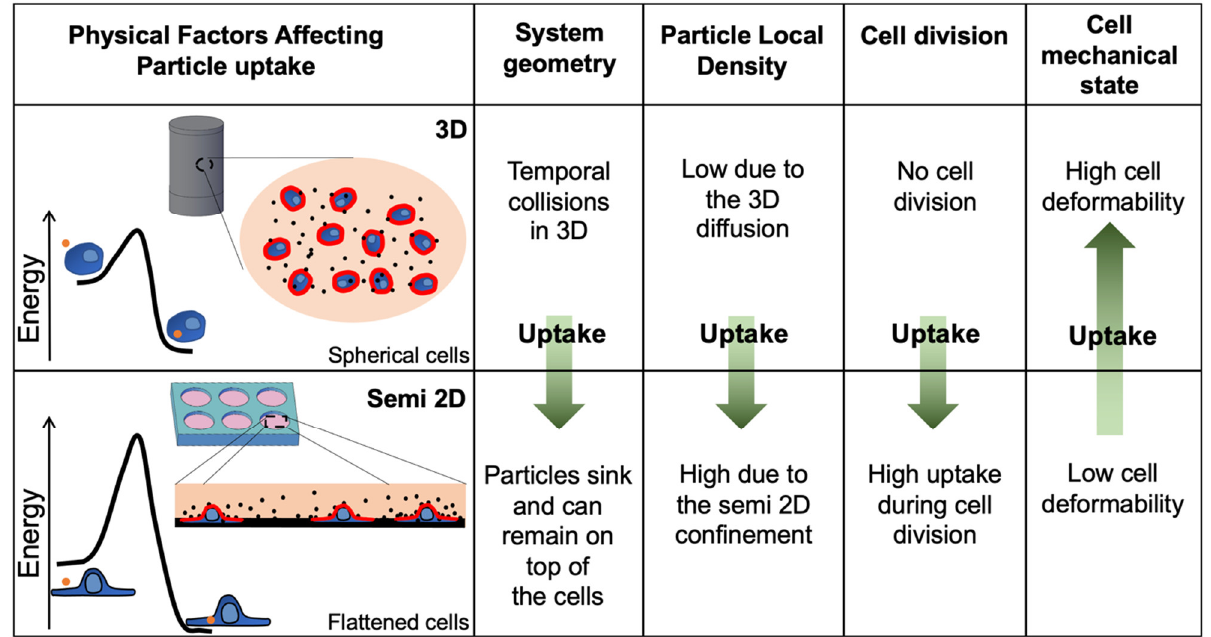
Figure 7. Physical differences between floating and adherent cells affect the uptake kinetics. While several factors favor uptake in the plate, the softness of cells, which favors fast uptake in 3DCFS, is a major term which eventually affects the fast kinetics of particle internalization into the floating cells. The collision rate was expected to be higher in the 2D plate mainly due to the system geometry and to the local density of the particles. In addition, many of the uptake events occurred during cell division while in the 3DCFS, cells did not divide. The observation showing much faster kinetics during the first hours indicated that the major factor was the mechanical flexibility of the cells, which lowered the kinetic barrier in the adhesive interaction between the particles and the cells and allowed for rapid turnover of active deformability of the cells during particle